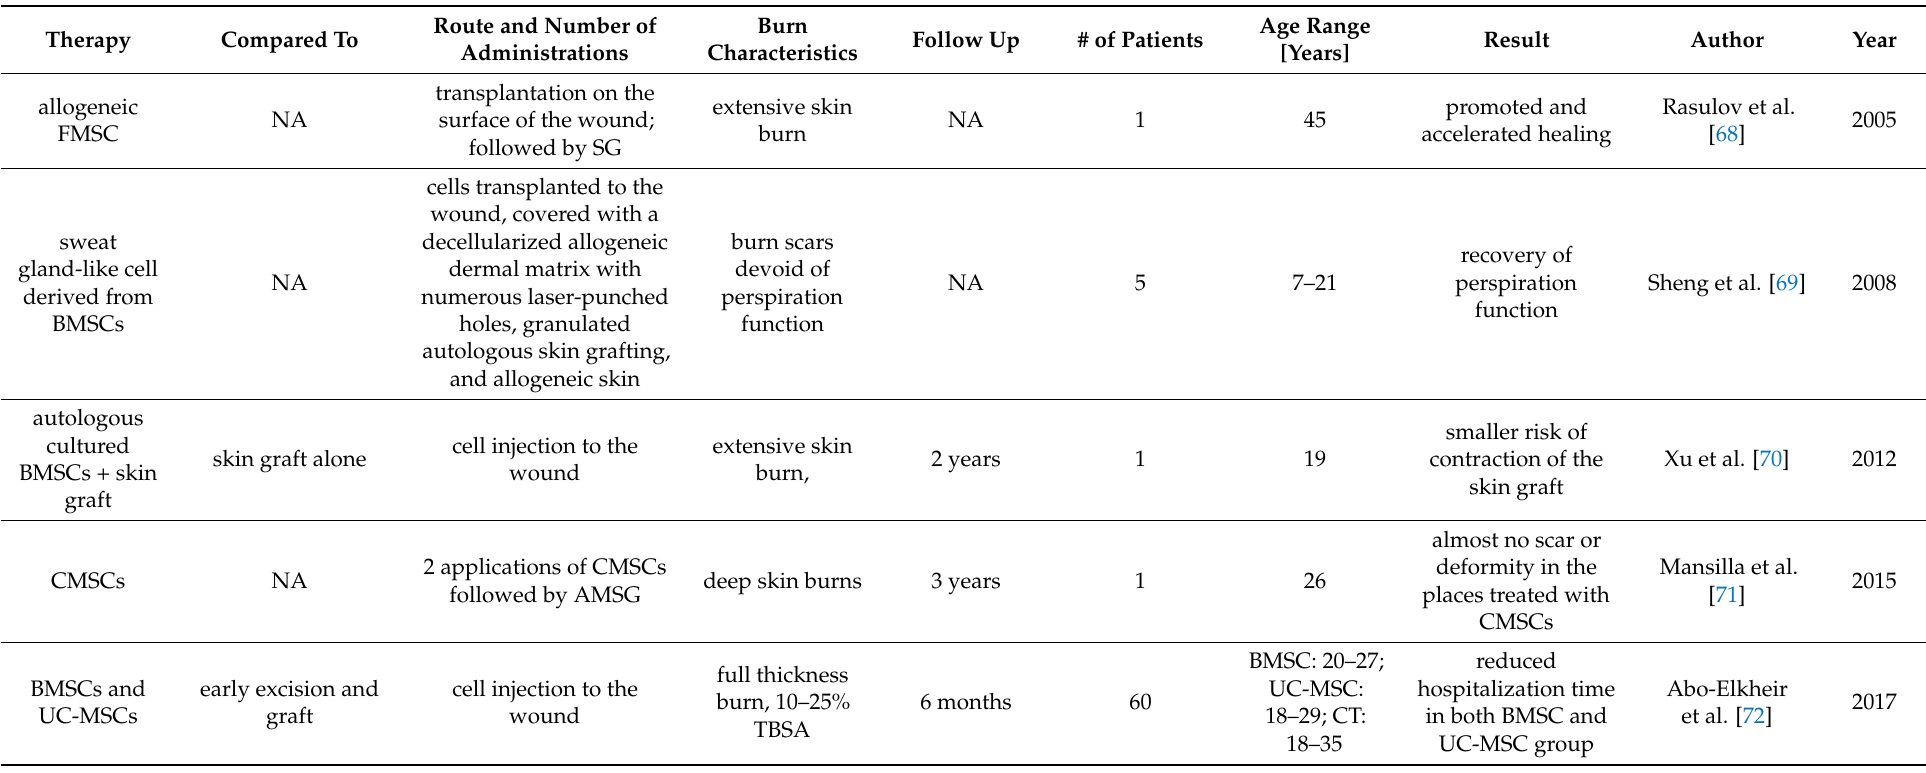
Table 3. Clinical applications of mesenchymal stem cells in burns (CMSCs—cadaveric bone marrow mesenchymal stem cells, NA—not available, AMSG—autologous meshed skin grafting, FMSC—fibroblast-like bone marrow mesenchymal stem cells, SG—skin grafts, BMSCs—bone marrow mesenchymal stem cells, UC-MSCs—umbilical cord blood-derived mesenchymal stem cells, TBSA—total body surface